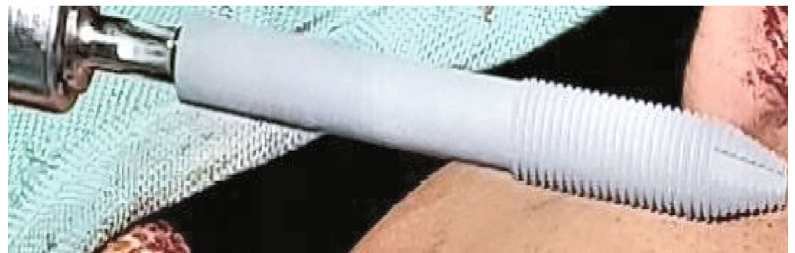
Figure 3: Zygomatic implant.